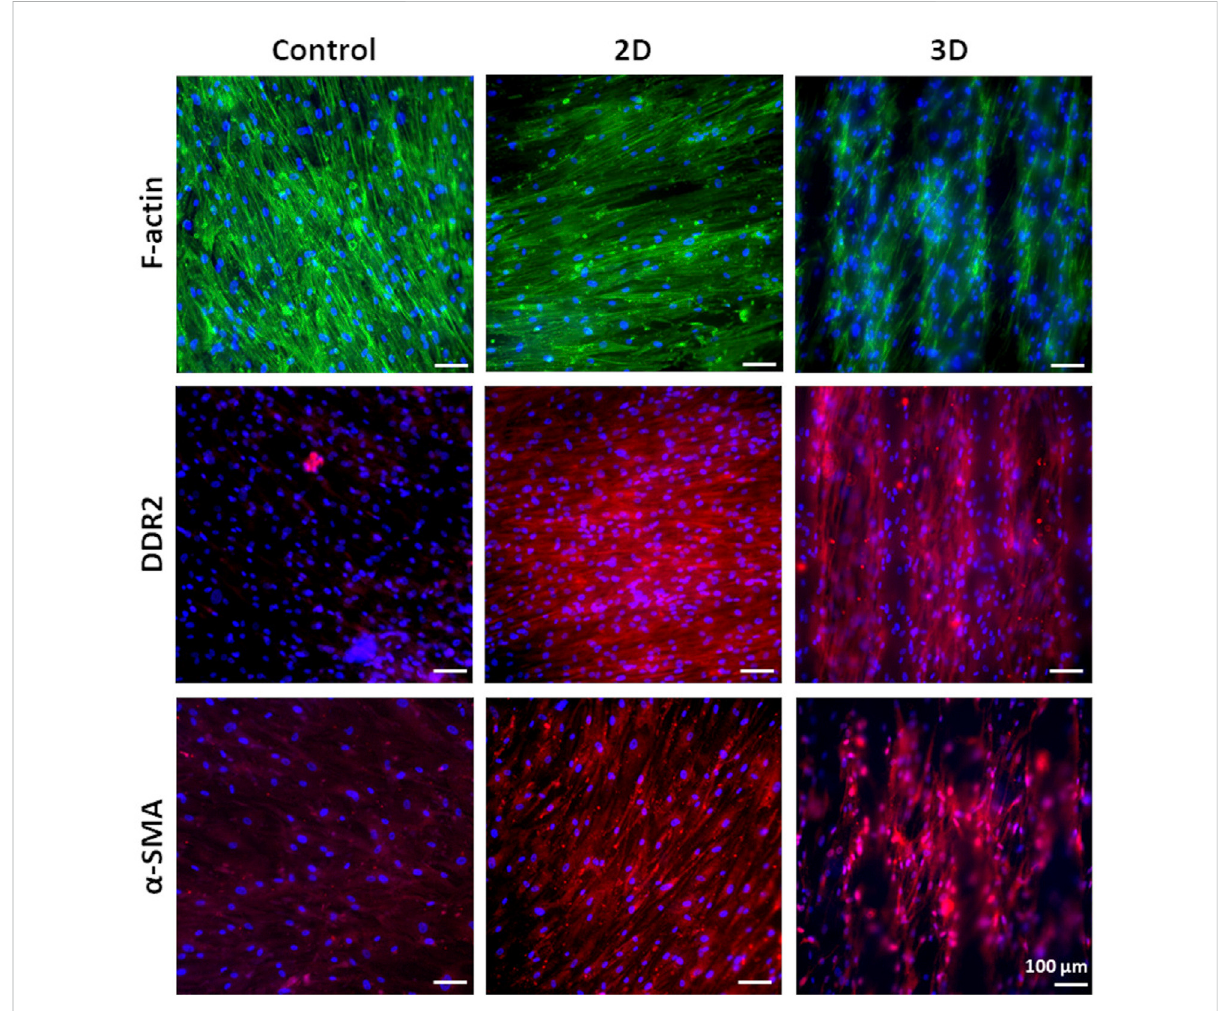
FIGURE 6 Phalloidin staining for F-actin and immuno fl uorescence analysis for DDR2 and α -SMA on v-HCFs cultured for 3 weeks on PCL/polyDOPA/G scaffolds and G-coated glass samples (control conditions). Cell nuclei were counterstained in blue with DAPI.